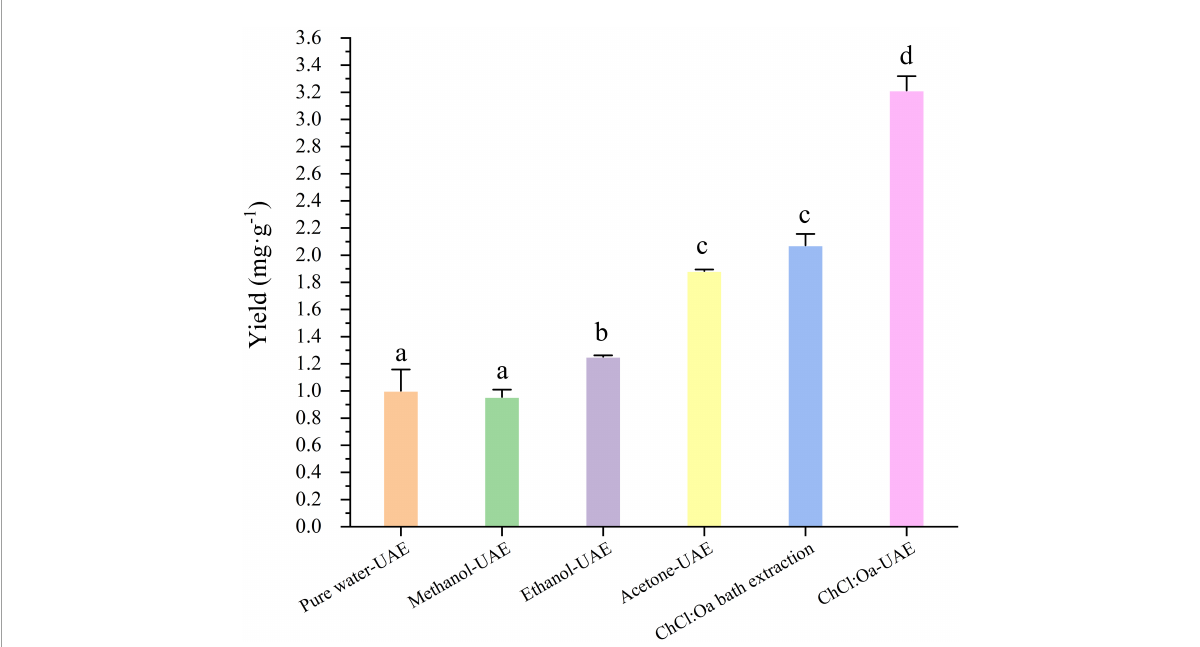
FIGURE4 Effects of pure water-ultrasound assisted extraction (UAE), methanol-UAE, ethanol-UAE, acetone-UAE, choline chloride-oxalic acid (ChCl:Oa) bath extraction and choline chloride-oxalic acid-ultrasound assisted extraction (ChCl:Oa-UAE) on ellagic acid (EA) yields. (Different lowercase letters represent P < 0.05, otherwise P > 0.05, n =